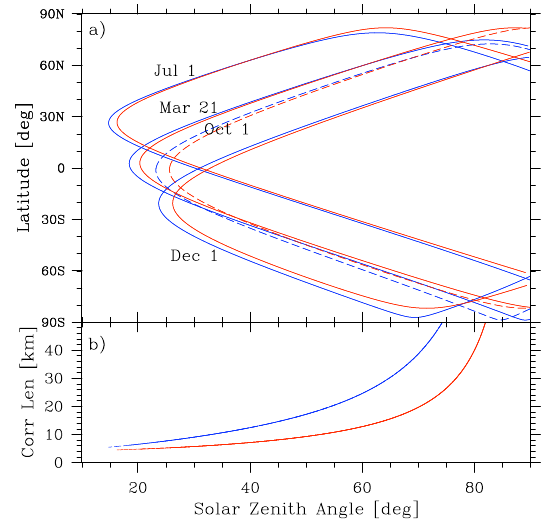
Fig. 5. (a) The solar zenith angles (SZA) encountered in nadir (red) and glint (blue) pointing modes for four times of the year, plot- ted against FOV latitude. (The 1 October–12 March difference re- flects the east/west shift in the Sun’s position in the analemma). (b) The correlation length L beyond which measurement errors are as- sumed to be independent, for nadir (red) and glint (blue), as given by Eq.